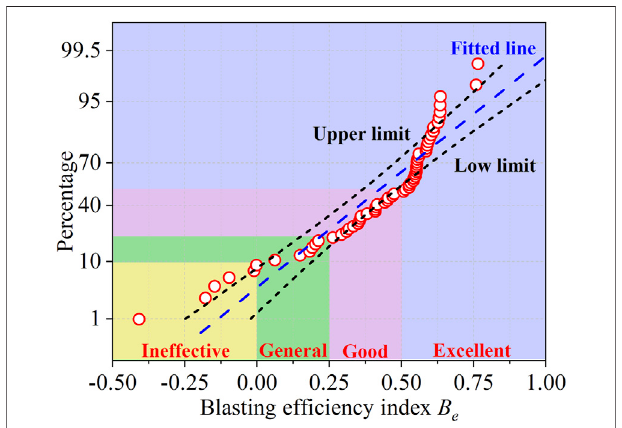
FIGURE 11 | Relationship between the blasting ef fi ciency index and explosive